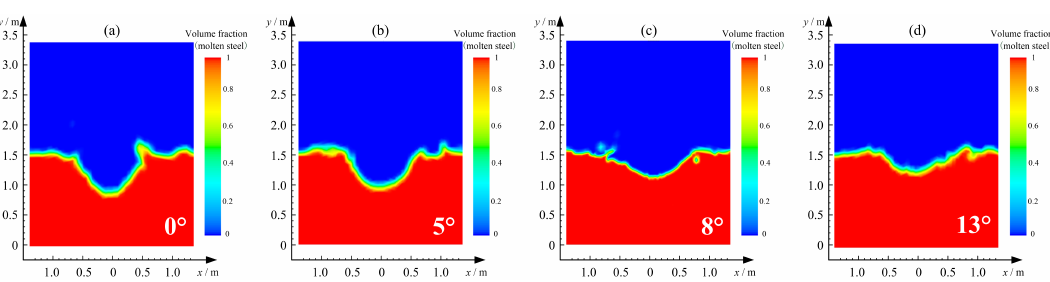
Figure 7. Volume fraction profiles in top-blowing steelmaking with different multi-nozzle oxygen lances. ( a ) NTA = 0 ◦ ( b ) NTA = 5 ◦ ( c ) NTA = 8 ◦ ( d ) NTA = 13 ◦